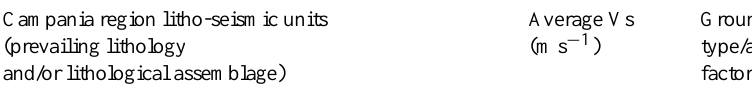
Table 4. Litho-seismic unit classification for the territories of Campania region and Ischia Island. Amplification factors from Eurocode 8 (2003). Modified after Rapolla et al. (2010,